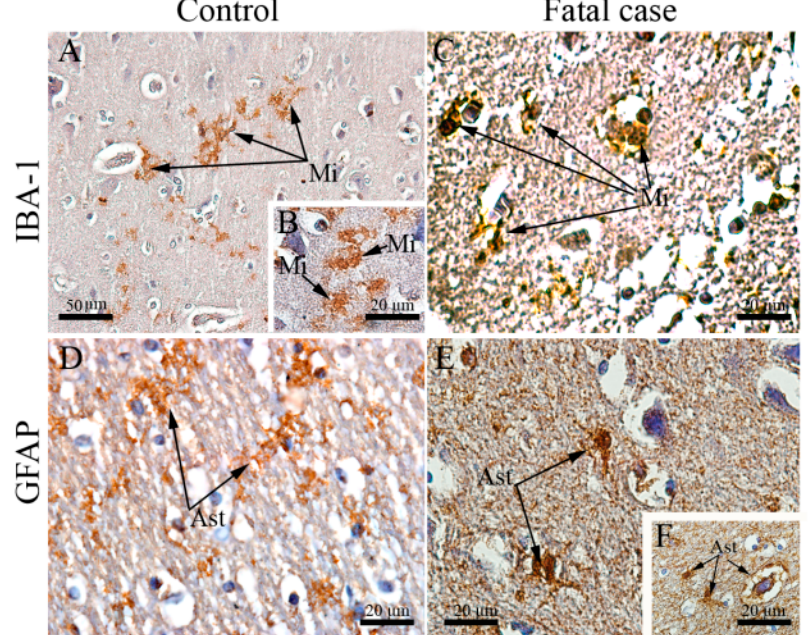
Figure 2. Aspects of microglia and astrocytes in brain tissue of fatal dengue cases. ( A , B ) Brain of a non-dengue case exhibiting microglia with normal aspect; ( C ) Brain section of DENV fatal case noting altered microglia with extensions retraction; ( D ) Brain of a non-dengue case exhibiting astrocytes with normal aspect; ( E , F ) Brain section of DENV fatal case showing altered astrocytes with thicker extensions. Mi—Microglia, Ast—Astrocytes.